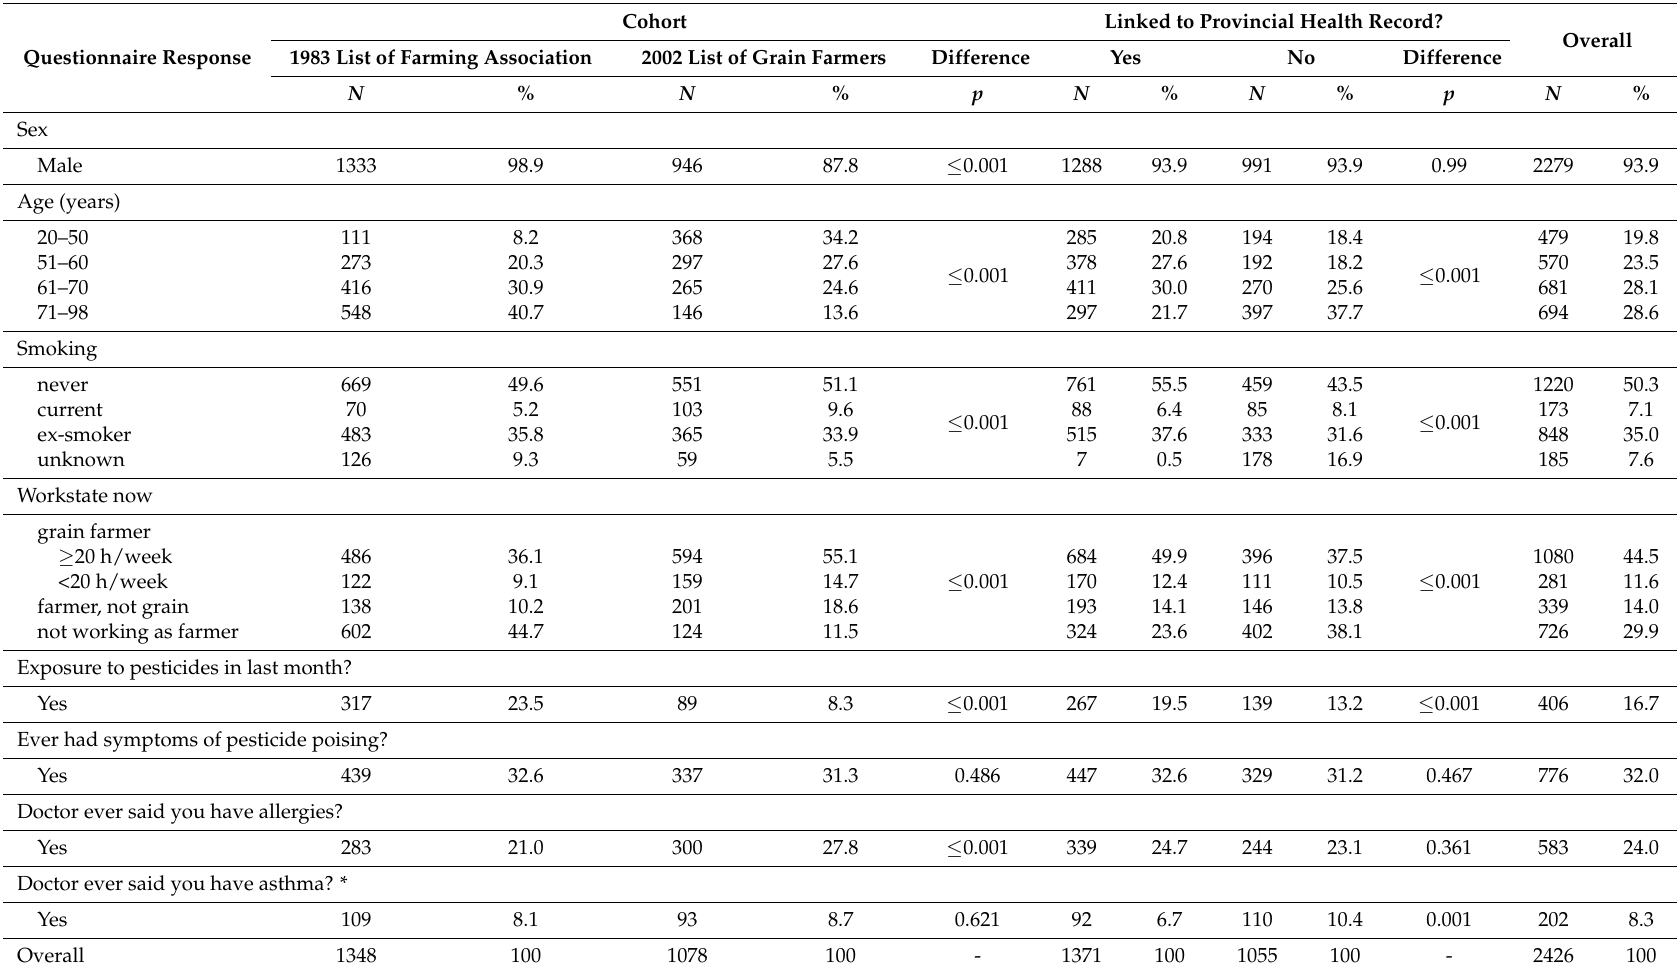
Table 1. Demographic, work and self-reported exposure, allergy and asthma by cohort and record